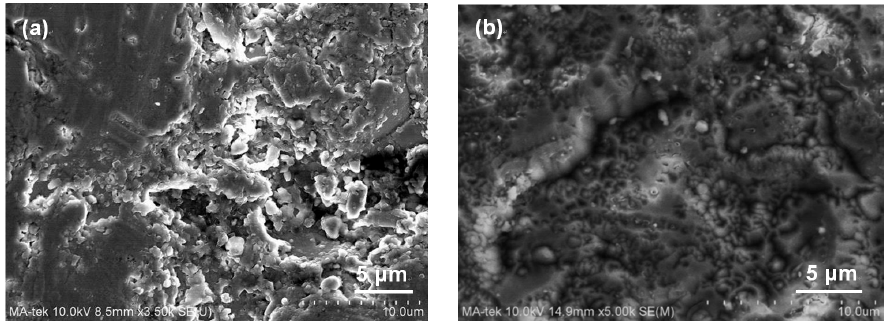
Figure 3. SEM images after fluorocarbon plasma treatment: ( a ) Y 2 O 3 and ( b ) YF 3 coatings.